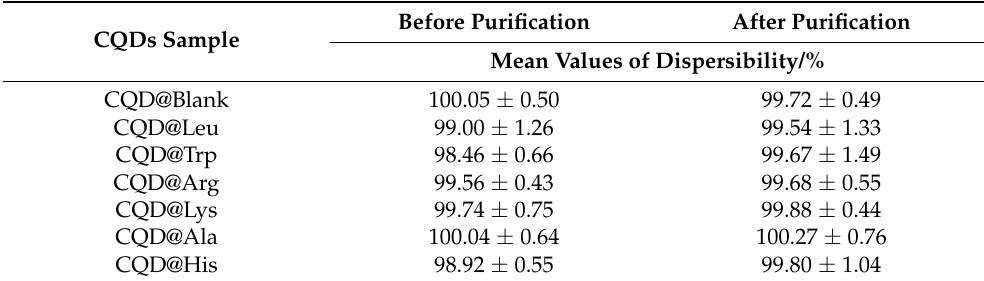
Table 3. Dispersibility of the prepared CQDs before and after sample